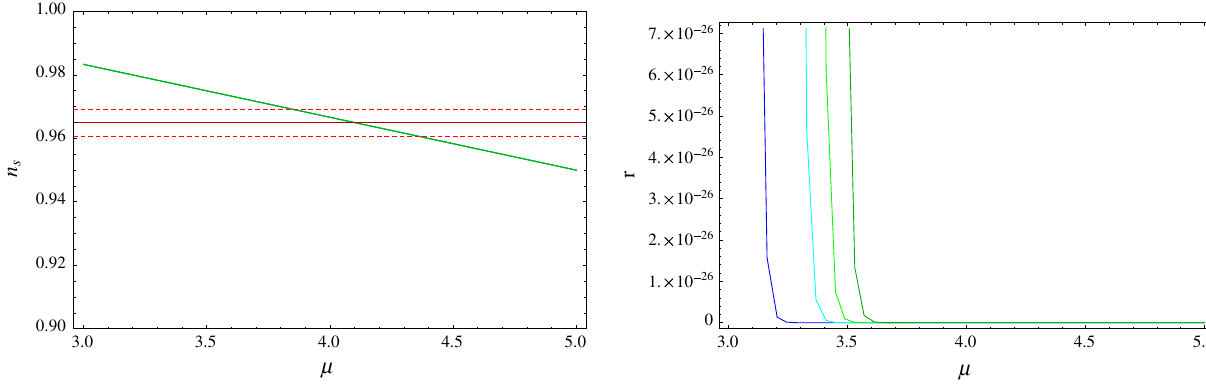
Fig. 1 The spectral index n S (left plot) and the tensor-to-scalar ratio r (right plot), for the power-law function h (χ) = γχ b in the case of a de Sitterevolution,withrespectto b ,for N = 50, γ = 1and μ = 10 12 s − 1 . The different colors correspond to different values of H 0 , varying from H 0 = 10 26 s − 1 (the blue curve) to H 0 = 10 29 s − 1 (the darker green